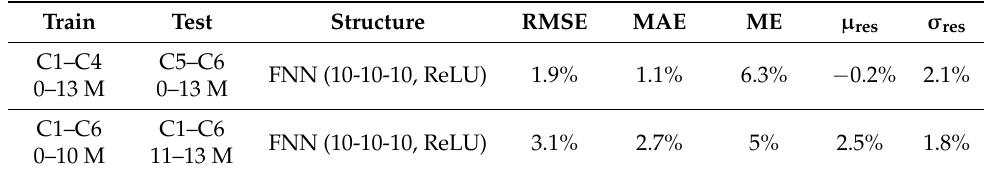
Table 7. Test results with combined impedance